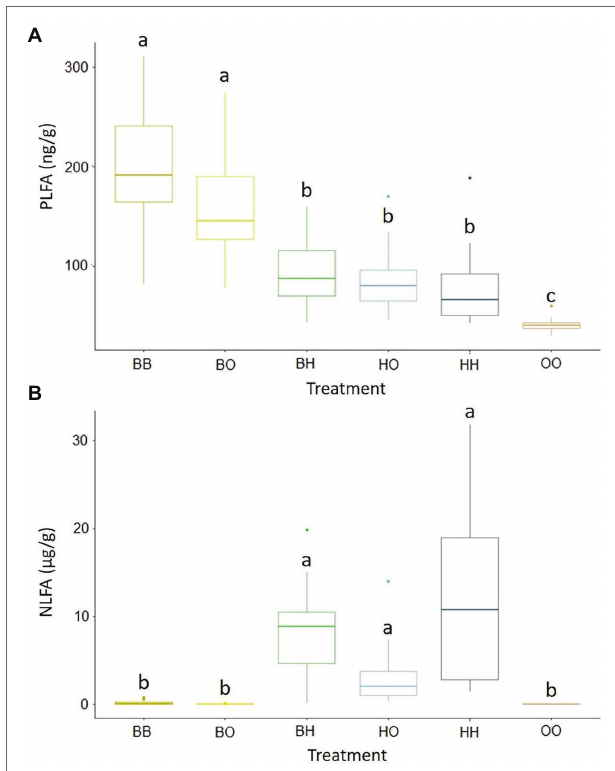
FIGURE 2 | Concentrations of phospholipid fatty acid analysis (PLFA) 18:2 ω 6.9 (A) , an estimator of total fungal biomass, and neutral lipid fatty acid analysis (NLFA) 16:1 ω 5 (B) , an estimator of arbuscular mycorrhizal fungal biomass, in the middle compartments of the experimental treatments. Different letters above the boxplots indicate significant differences between treatments. The midline of the boxplots is the median, the upper and lower limits of the box the third and first quartile, respectively. Whiskers extend to 1.5 times the interquartile range from the top (bottom) of the box ( n = 16). Treatments: 00 = without plants in lateral compartments, B0 = B. pendula in only one lateral compartment, BB = B. pendula in both lateral compartments, BH = B. pendula and H. caespitosum in lateral compartments (interaction treatment), H0 = H. caespitosum in only one lateral compartment, HH = H. caespitosum in both lateral